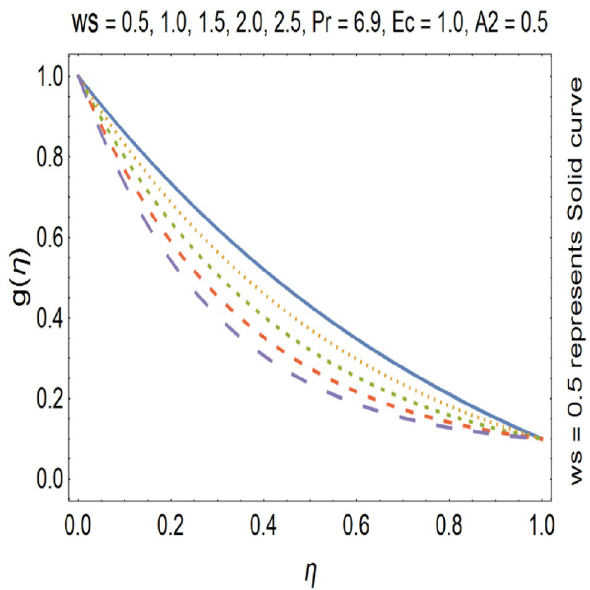
Figure 15. Tangential velocity profile for various ws.